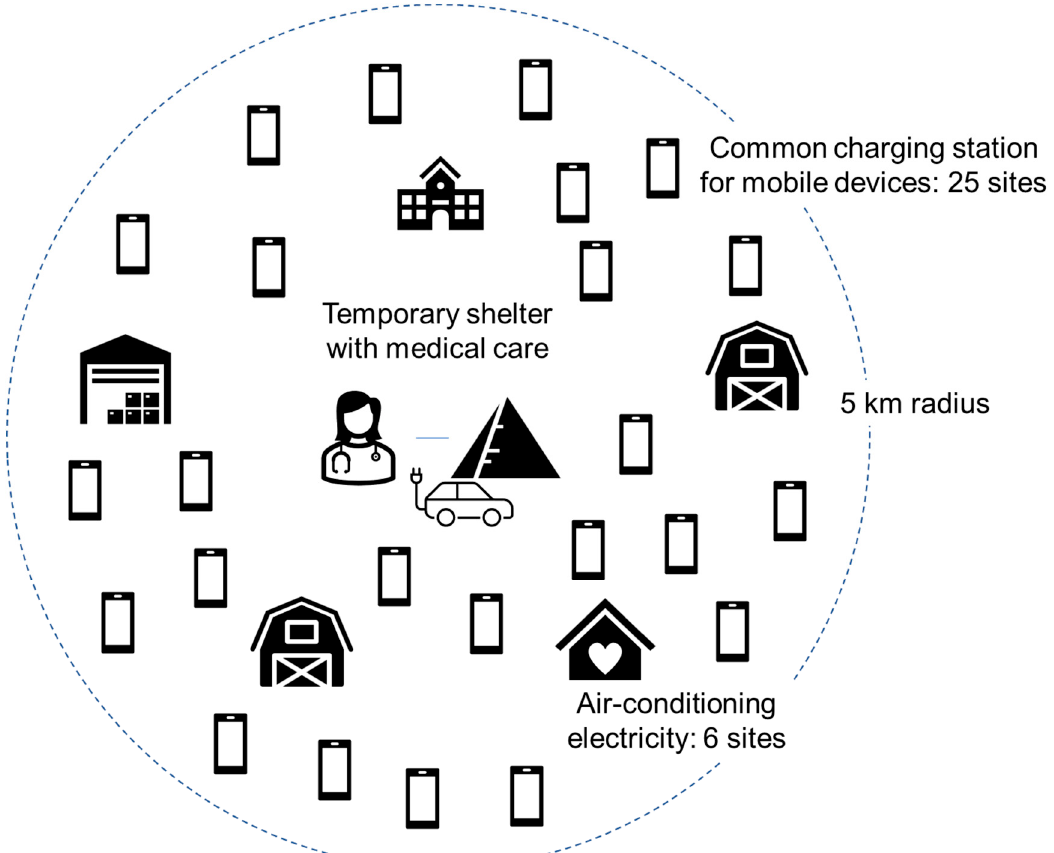
Figure 2. Resilience facilities in addition to the standard facilities in Figure 2, powered by voluntary electricity contributions from SEVs and VIPVs. Table 3. Energy demand by time of day in resilience facilities supported by VIPV.